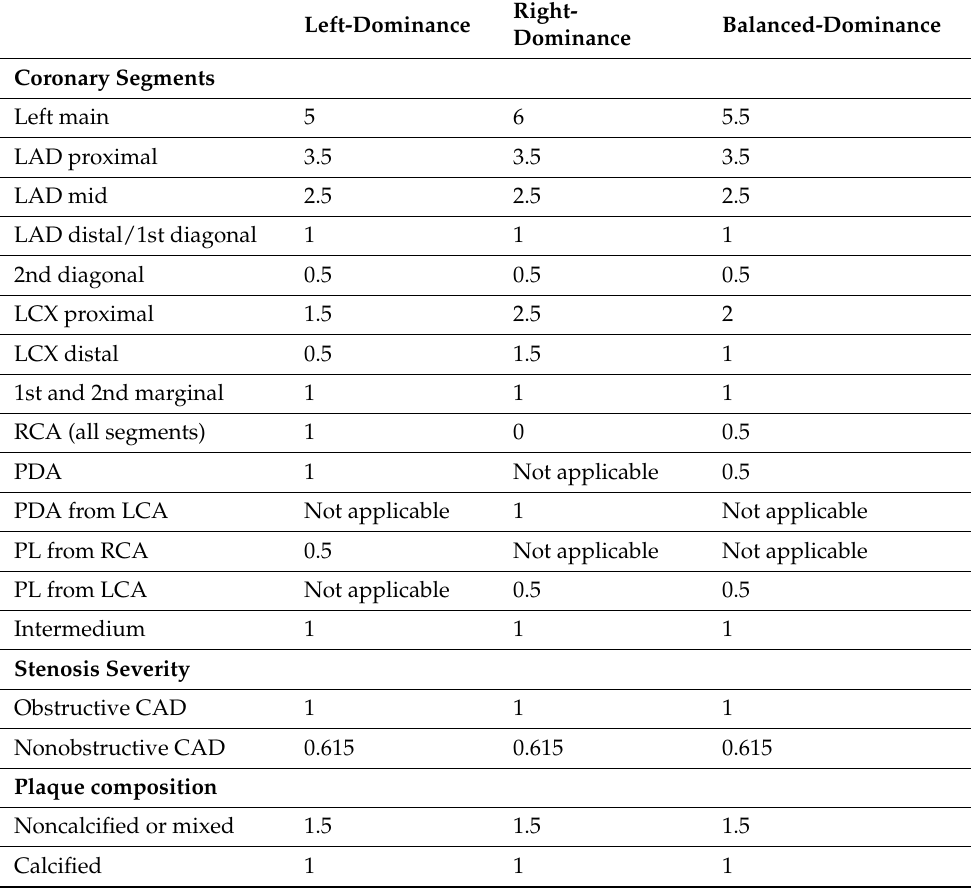
Table 1. CT-adapted Leaman score.